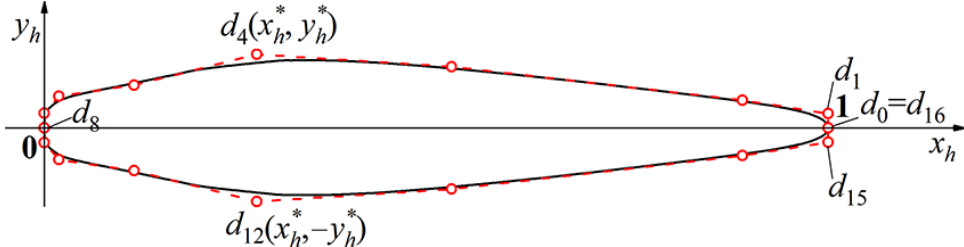
Figure 3. Thickness distribution model for streamlined torque converter